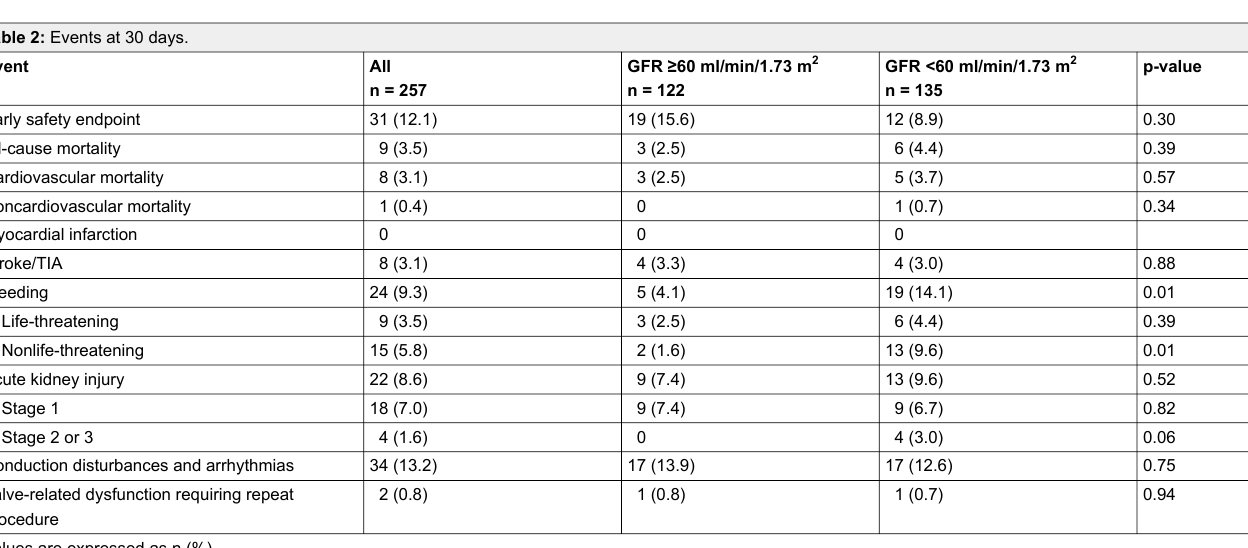
Table 2: Events at 30